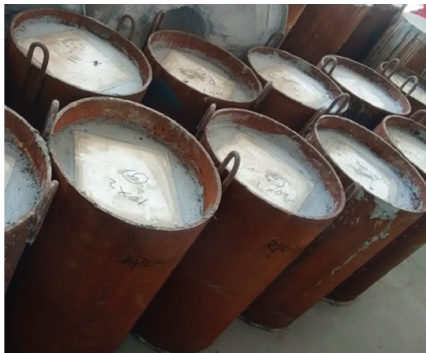
Figure 3: C-RPC composite targets.